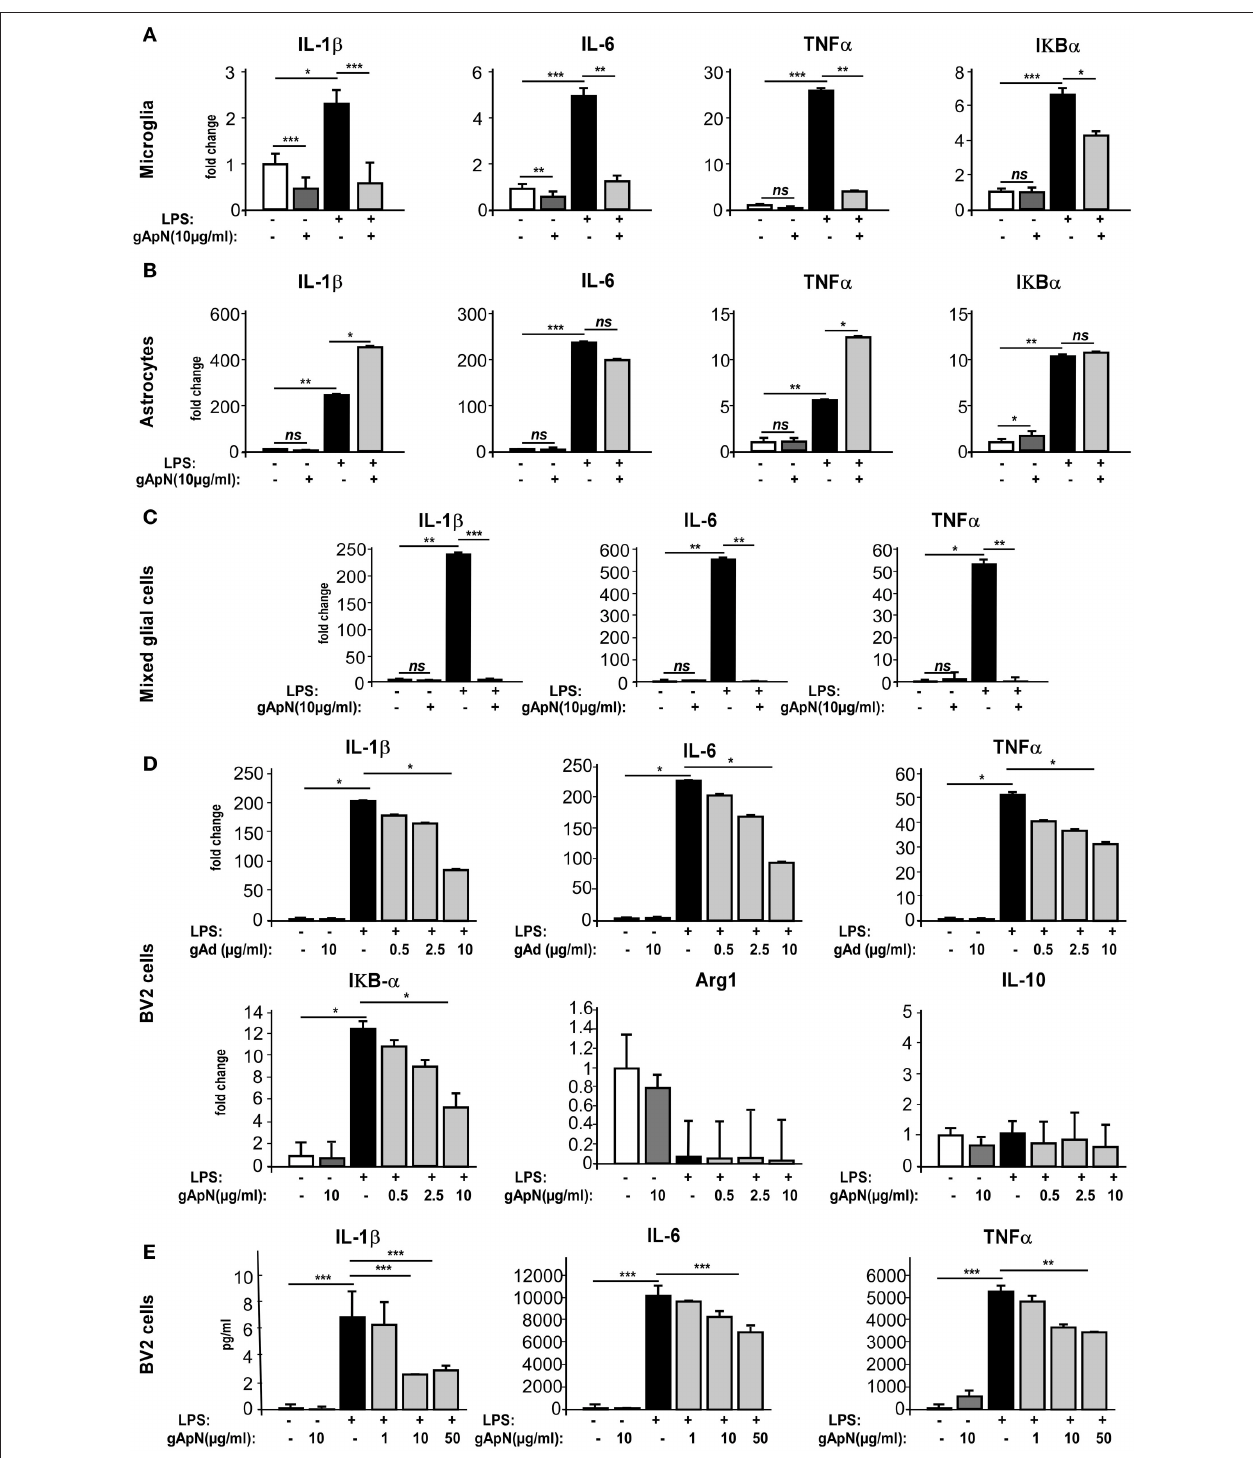
FIGURE 4 | Globular adiponectin limits LPS-induced pro-inflammatory activation of microglia but not astrocytes. (A–C) Primary cultures of microglia or astrocytes or both were obtained as described in the Materials and Methods section. Microglia (A) , astrocytes (B) , mixed glial cells (C), or BV2 cells (D,E) were pre-treated with saline (white and black bars) or gApN (gray bars) before treatment with saline (white and dark gray bars) or LPS (black and light gray bars). Levels of IL-1 β , IL-6, TNF α , and I κ B- α mRNAs (A–D) or proteins (E) were quantified by qRT-PCR and CBA, respectively. N 3–4 per group; Kruskal–Wallis test followed by the Iman-Conover = method for multiple comparison between groups was performed, * p < 0.05, ** p < 0.01, *** p < 0.005; ns, non-significant.